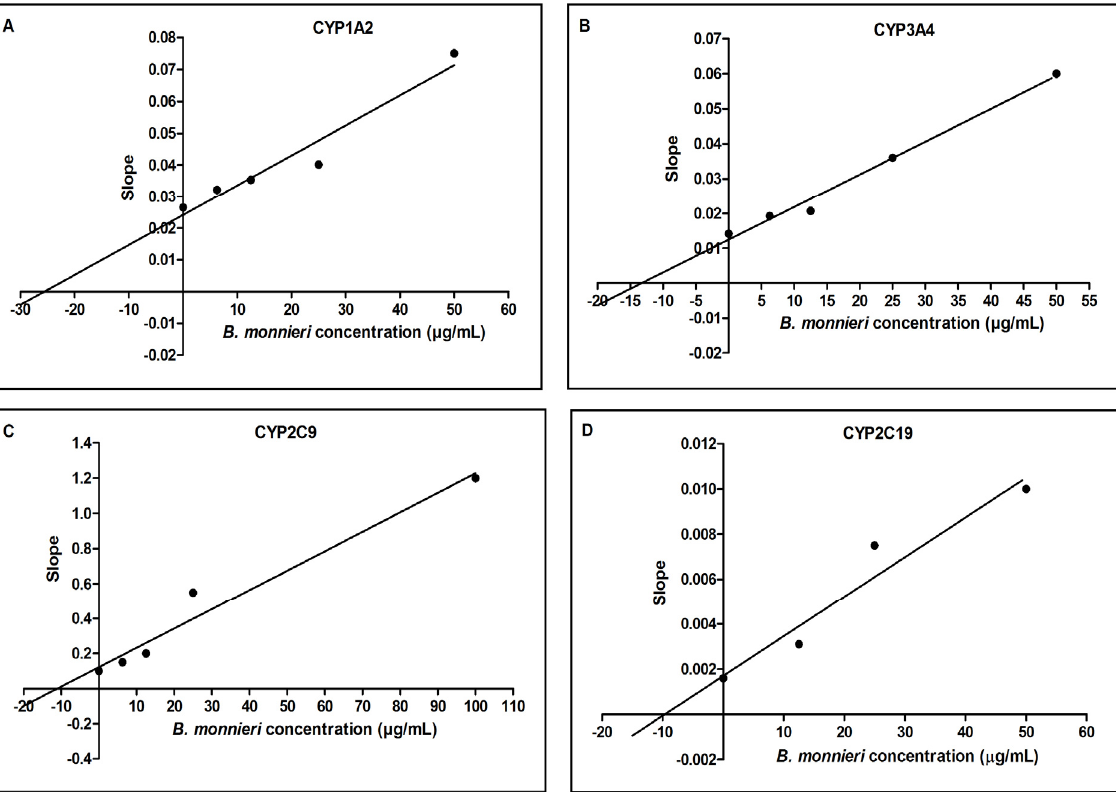
Figure 4. Ki values of B. monnieri extract for ( A ) CYP1A2; ( B ) CYP3A4; ( C ) CYP2C9 and ( D ) CYP2C19. Ki values were determined from secondary plots of CYP activity using the slopes of primary Lineweaver–Burk plot versus concentrations of B. monnieri